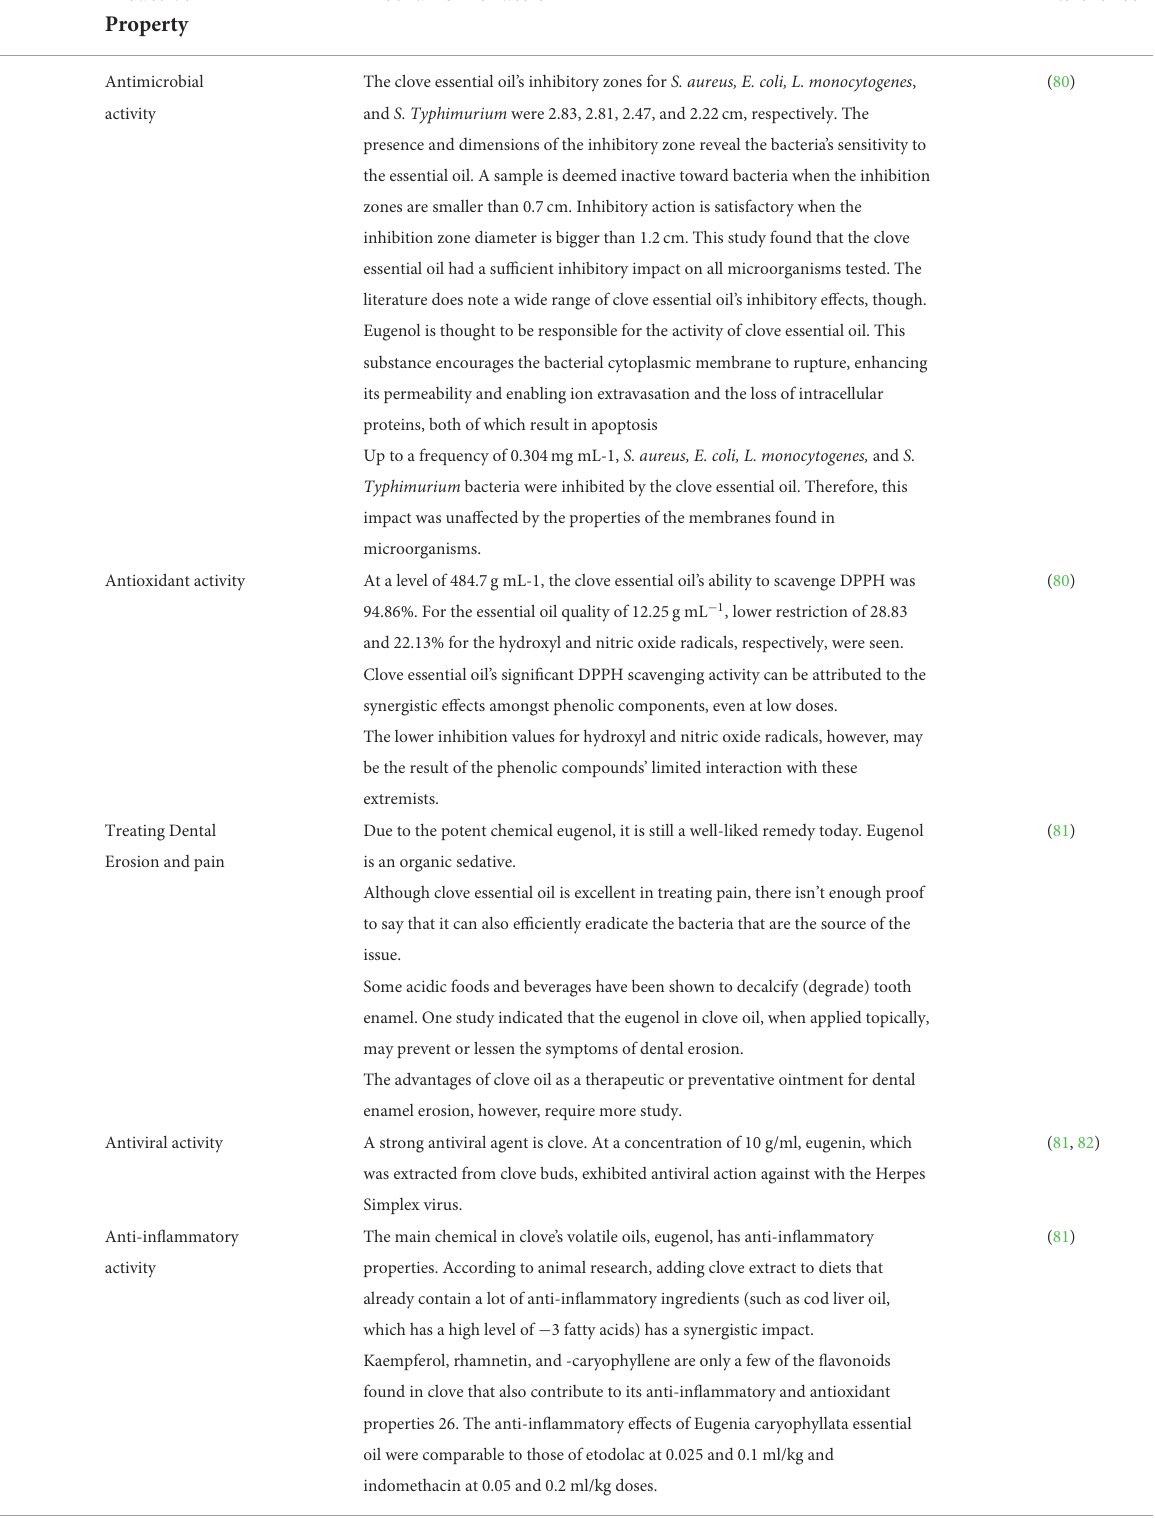
TABLE 3 Bioactive properties of CEO with mechanism of action.